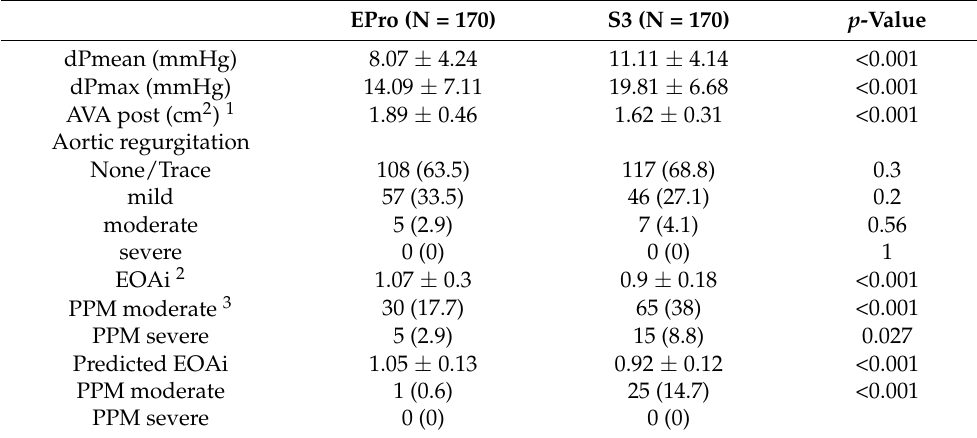
Table 3. Echocardiographic